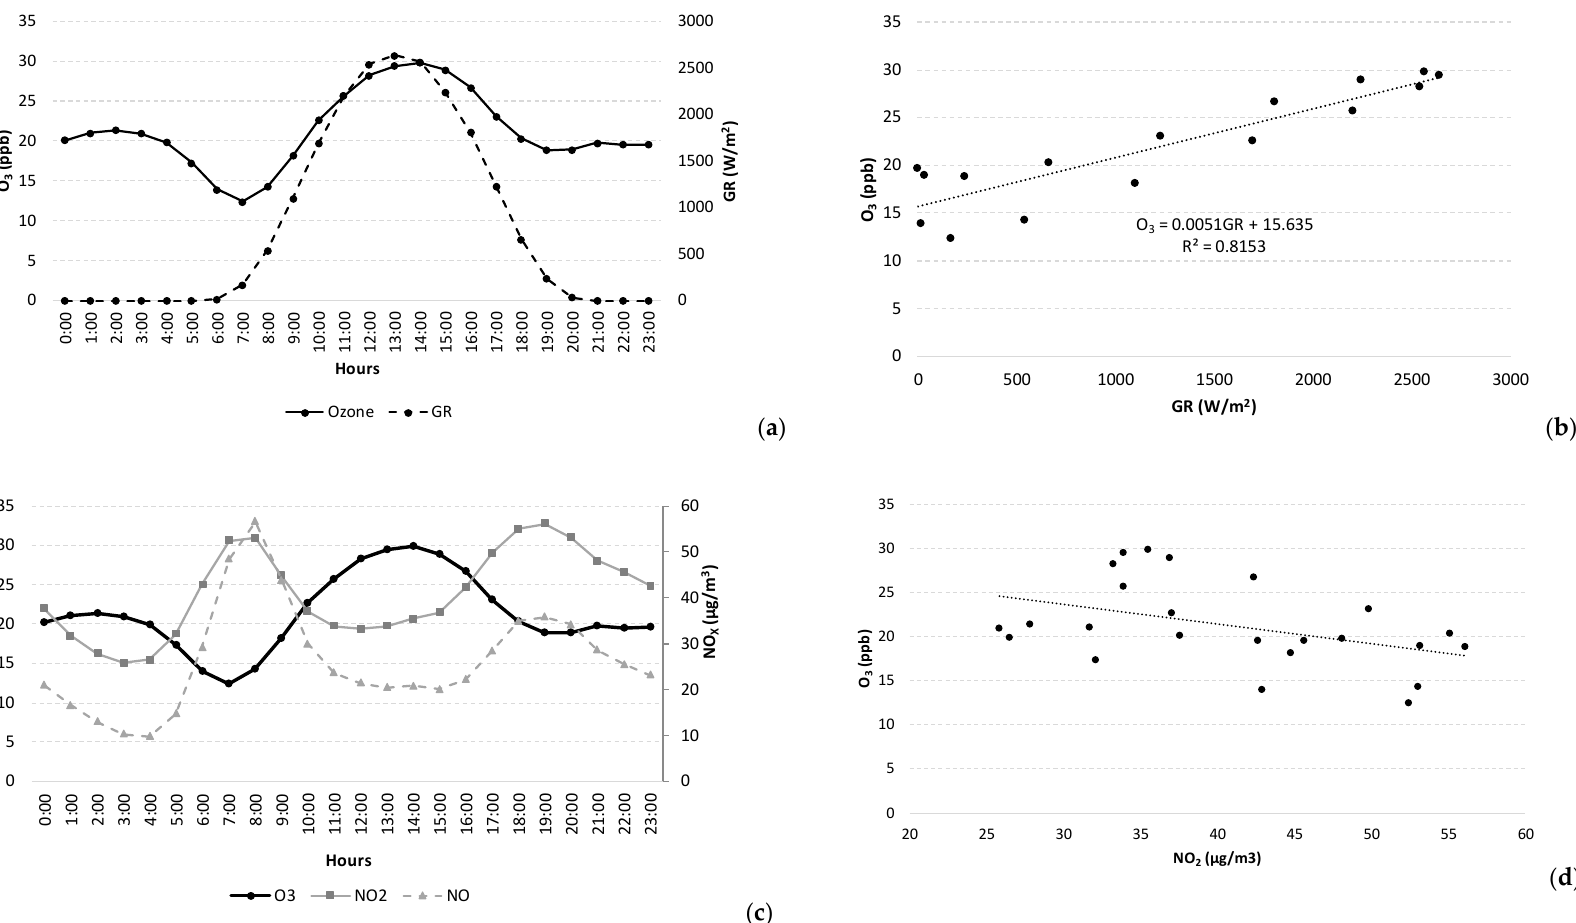
Figure 9. Tropospheric ozone correlations ( a ): average day of 2017 ozone with GR; ( b ): average daytime of 2017 ozone with GR; ( c ): school period weekday ozone with NOx and ( d ): average day of 2017 ozone with NO 2 .